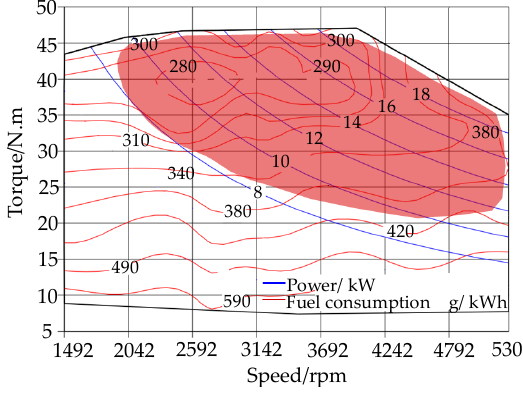
Figure 4. Engine efficiency map.